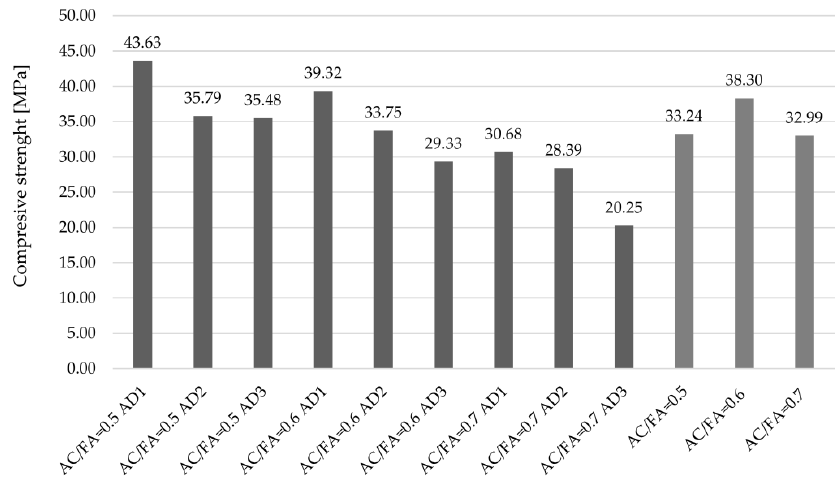
Figure 3. Compressive strength results for all the series.